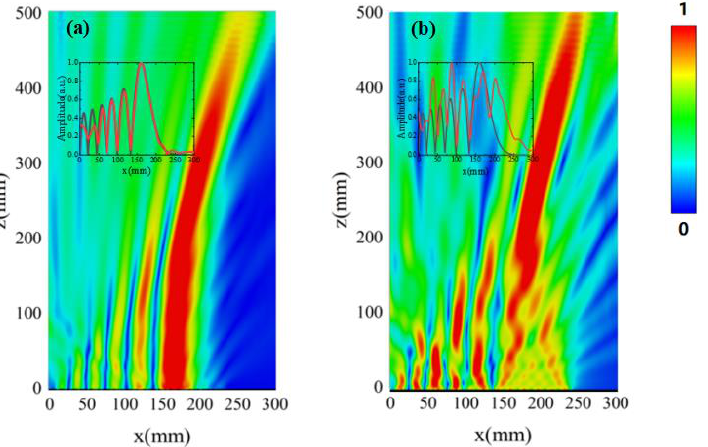
Figure 7. The electric field distribution of the generated Airy beam was simulated, as shown in ( a ) with full amplitude modulation, and ( b ) without amplitude modulation. (The inset compares the normalized intensities between the generated Airy beam (denoted by a red line) and ideal Airy beam (denoted by a black line) at a distance of 80 mm from the metasurfaces).